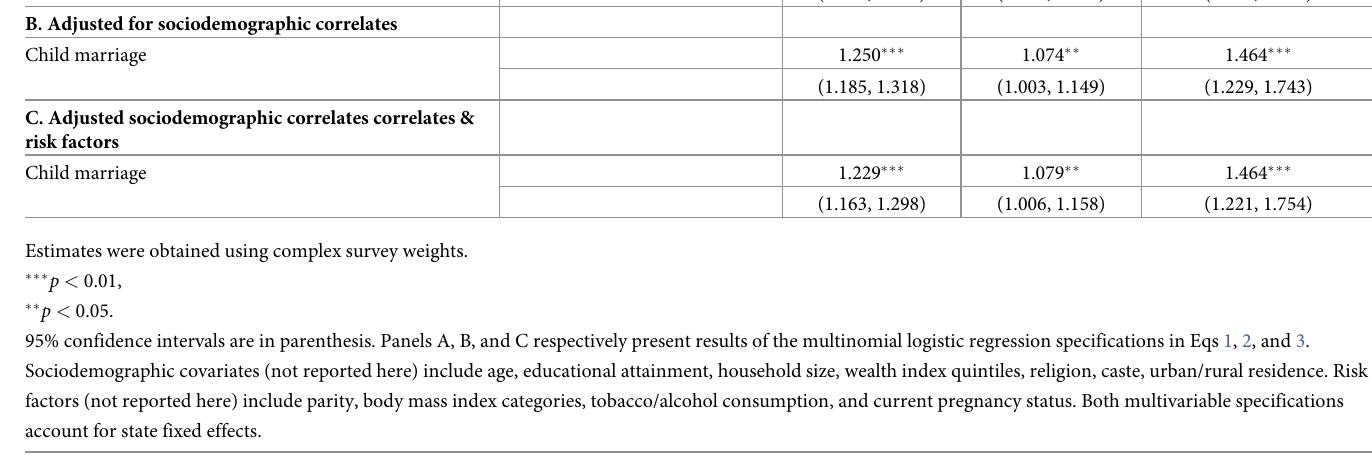
1.5 times that of those who were married as adults. The ARRRs for child marriage, across all three outcomes, adjusted of sociodemographic correlates and risk factors, persisted when we